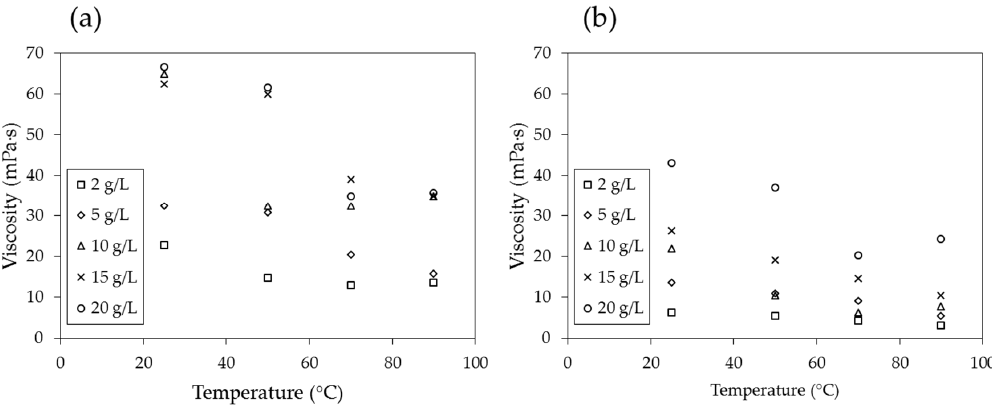
Figure 9. Viscosity with respect to temperature at shear rates of ( a ) 3.4 s − 1 and ( b ) 68 s − 1 .